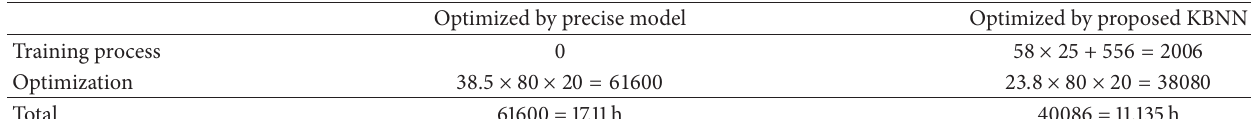
Table 9: Time of optimization by precise model and proposed KBNN comparison.